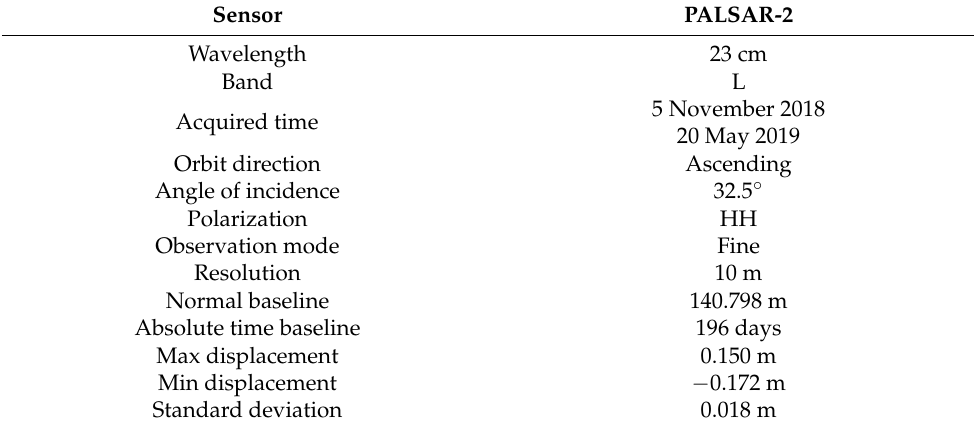
Table 2. Details of two SAR images and displacement from